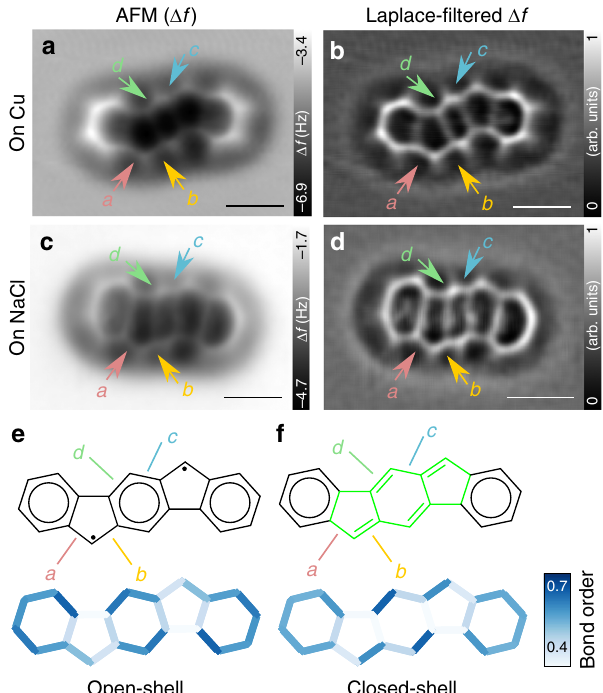
Fig. 6 Bond-order analyses. a , c Constant-height AFM images of IF taken with CO tip at V = 0 V on Cu(111) ( Δ z = − 2.1 Å) ( a ) and on 2 ML NaCl ( Δ z = 1.5 Å) ( c ). b , d To emphasise the structure of the molecule, Laplace- fi ltered AFM images are also shown. e , f Bond orders of IF in its open-shell ( e ) and closed-shell ( f ) resonance structures. The s -indacene moiety is highlighted in green ( f ). On the bond-order scale, 0 refers to a single bond and 1 to a double-bond 45 . Bond orders were determined by using the bond lengths of relaxed geometries. Scale bars, 500